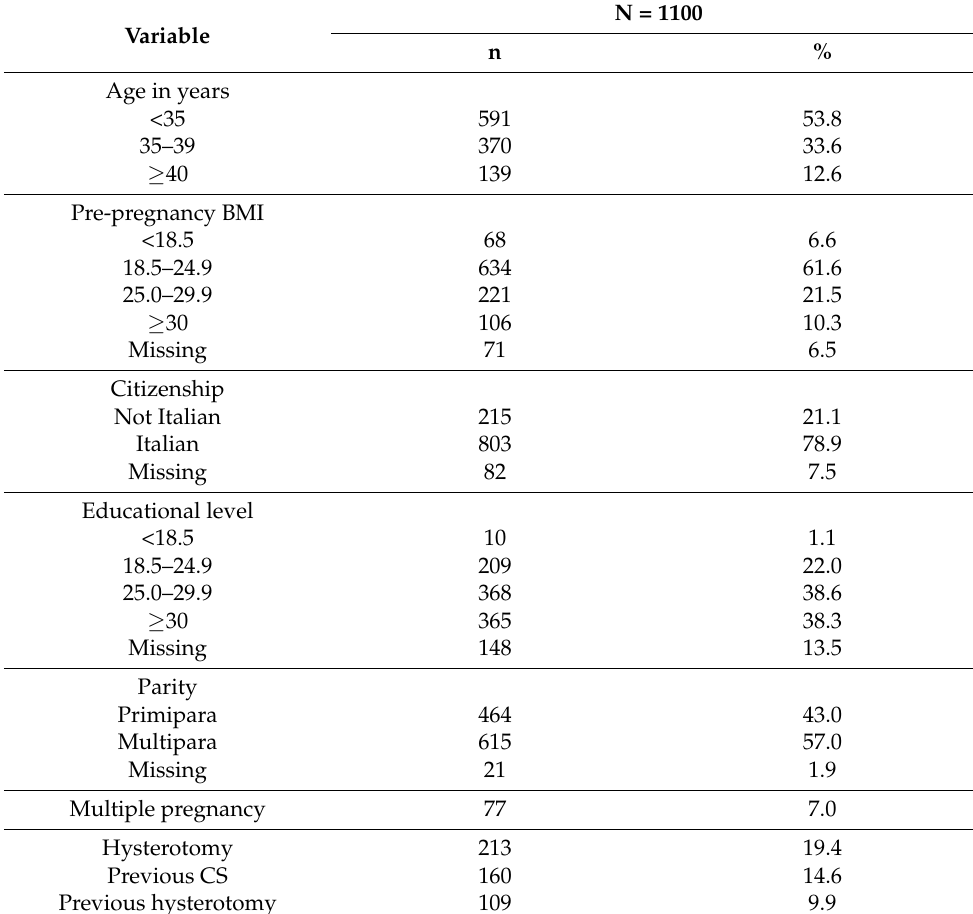
Table 2. Women’s socio-demographic and obstetric